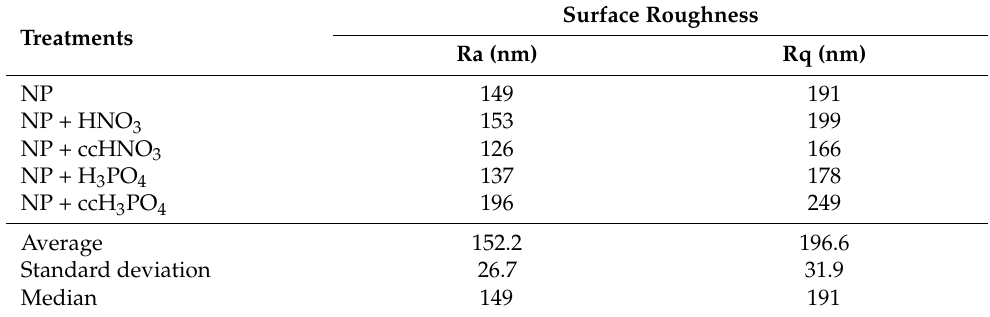
Table 2. Surface roughness of samples measured using optical profilometry. Ra: arithmetical mean height indicates the average of the absolute value along the sampling length; Rq: root mean square deviation indicates the root mean square along the sampling length. Regarding Ra, the surface roughness of the of samples remained in the range from 126 nm to 196 nm with an average of 152.2 nm ( ± 26.7 nm) and a median of 149 nm. Regarding Rq, the surface roughness values of the of samples ranged from 166nm to 249 nm with an average of 196.6nm ( ± 31.9 nm) and a median of 191